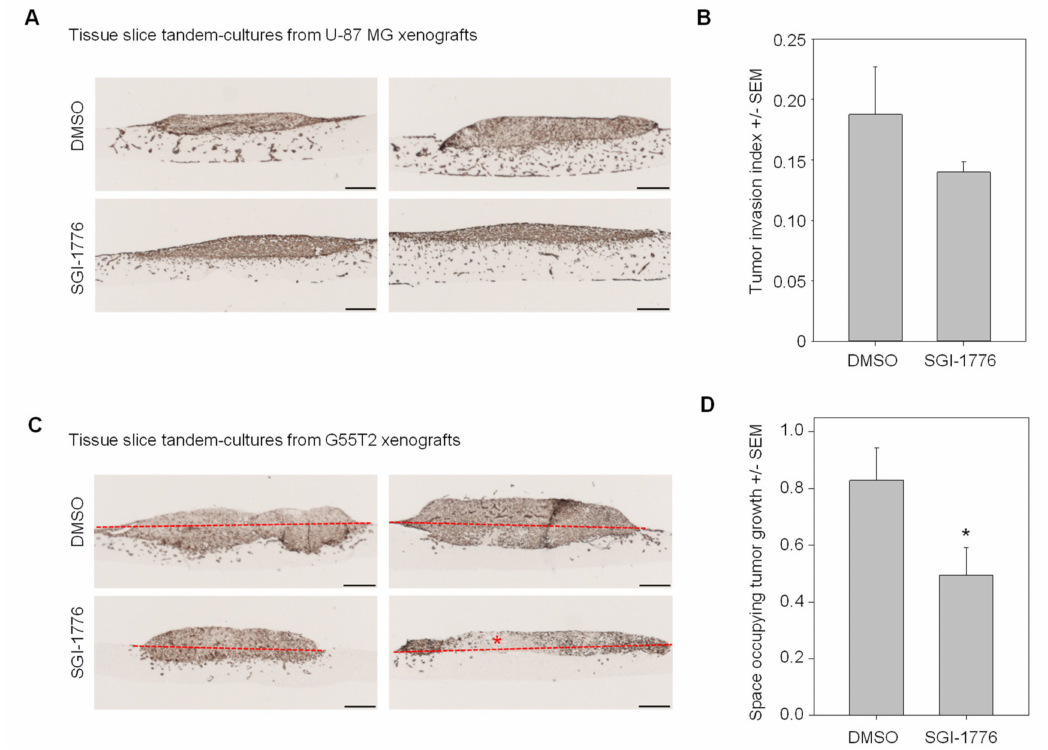
Figure 4. Treatment of xenograft tandem-cultures based on ( A , B ) U-87 MG or ( C , D ) G55T2 cell xenografts with the Pim1 inhibitor SGI-1776 vs. solvent control. ( A , C ) representative microscopic pictures of Vimentin staining (asterisk: necrotic area). ( B , D ) Results of the quantitation of the tumor invasion index or space occupying tumor growth. Scale bars: 200 µ m; * = p <